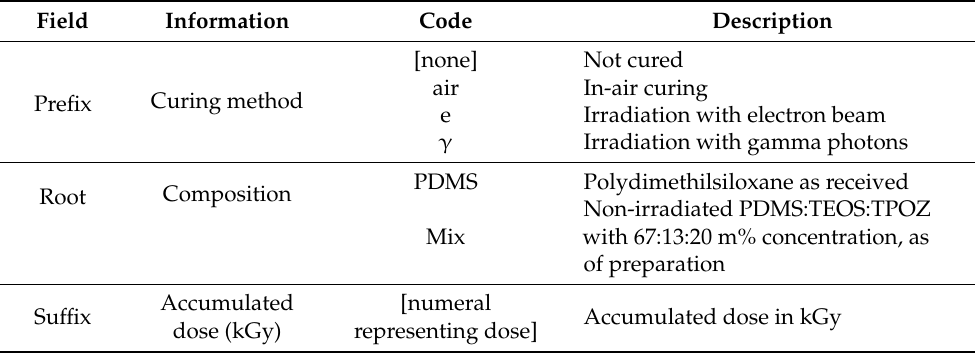
Table 1. Description of samples’ name